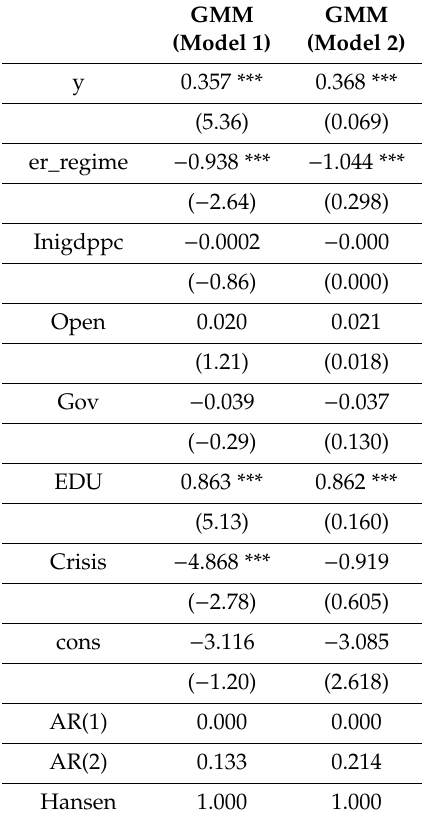
Table 4. Regression results of panel